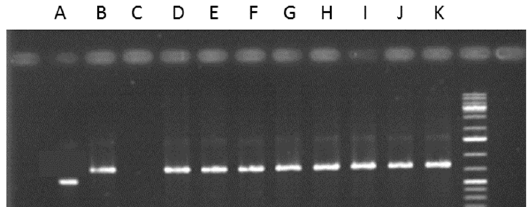
Figure 9. ITS_KYO2 primers used to determine the presence of fungal and plant DNA. A. Extracted endophytic fungi DNA isolated from C. roseus as positive control, B. Extracted DNA from C. roseus , C. Water as negative control, D. Control samples, E. Pronto Plus samples, F. Folicur samples, G. Switch samples, H. Control samples, I. Pronto Plus samples, J. Folicur samples, K. Switch samples. D–G = 7 days after treatment samples, H–K = 28 days after treatment samples.